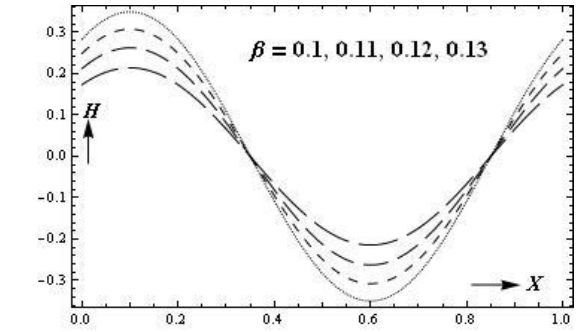
Figure 9 . Heat transfer coefficient for various values of slip